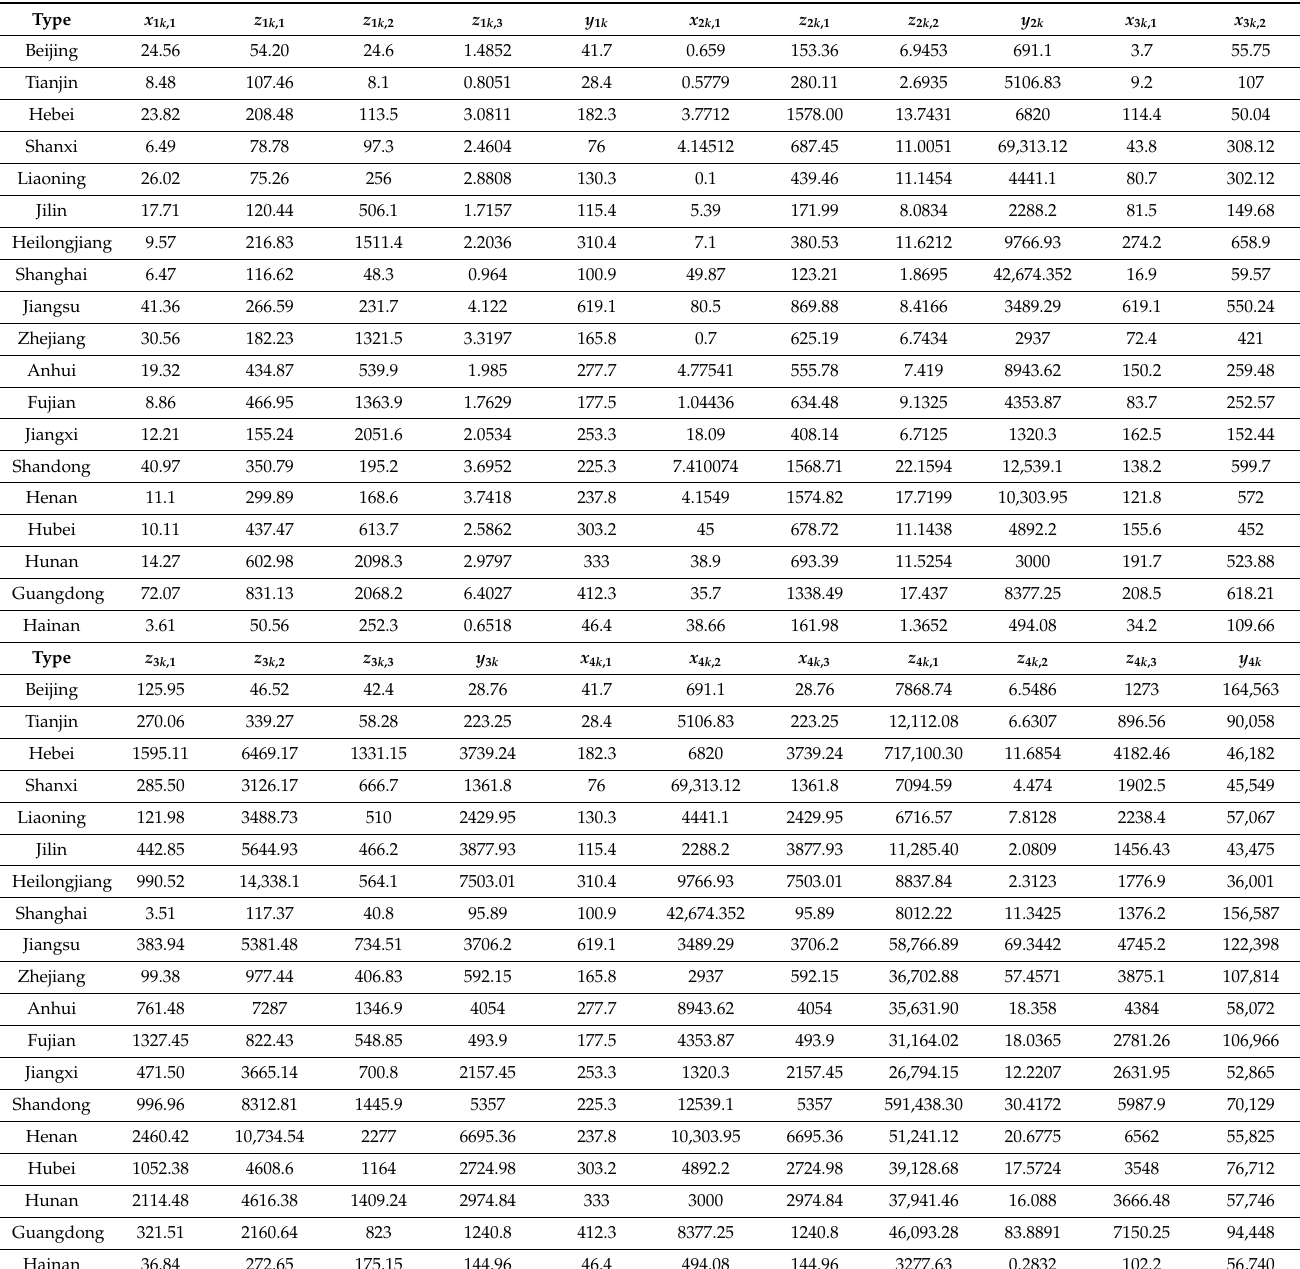
Table A2. Data of evaluation index